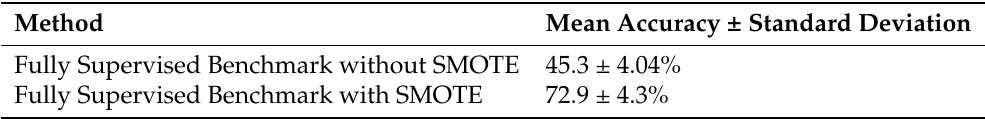
Table 6. The comparison of the performance of the fully supervised learning benchmark using RML dataset having been over-sampled with